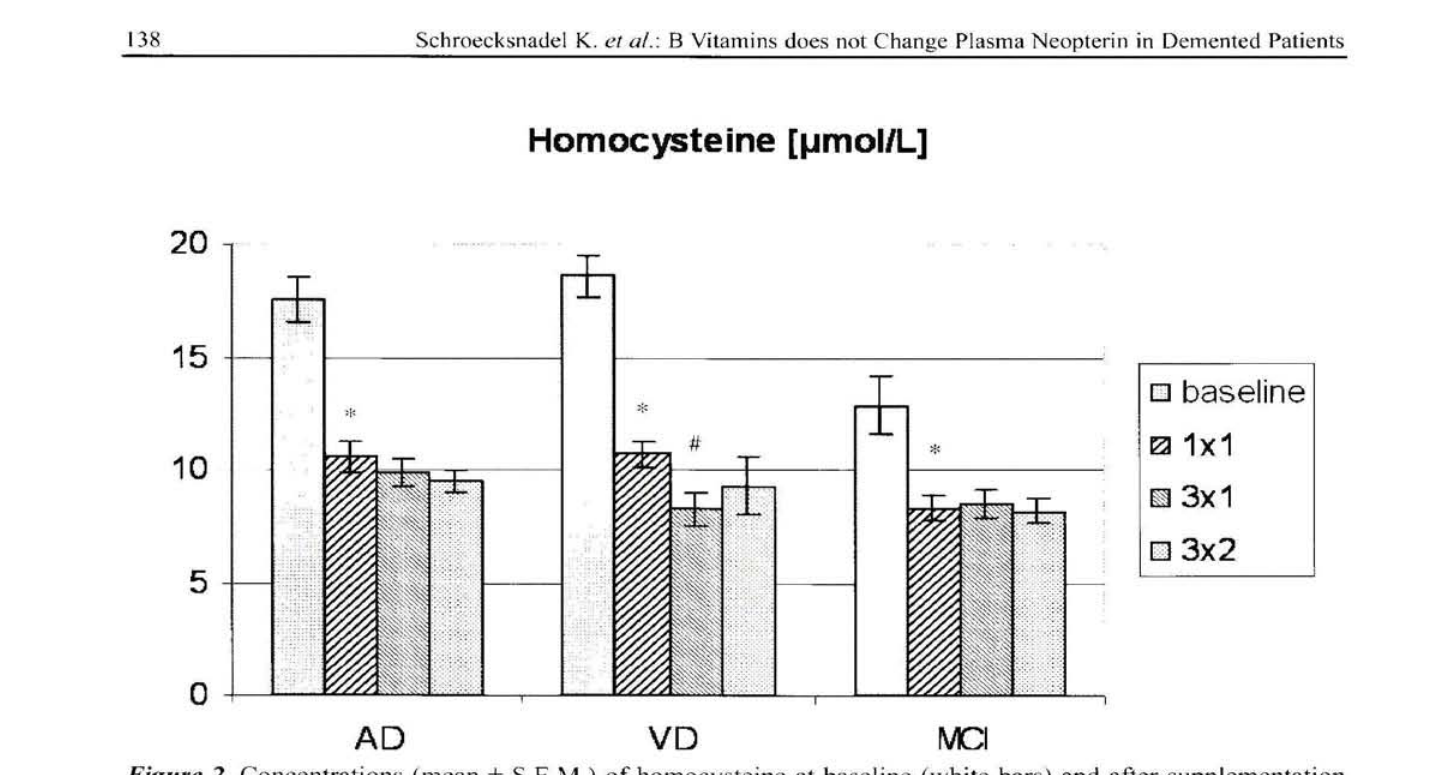
Figure 2. Concentrations (mean ± S.E.M.) of homocysteine at baseline (white bars) and after supplementation with Β vitamins ( Beneuran compositum TM lxl tablet/day, 3X1 tablets/day, 3X2 tablets/day - hatched bars) in patients with Alzheimer disease ( AD), vascular dementia (VD) and mild cognitive impairment (MCI); *p <0.01 compared to baseline, #p <0.01 compared to concentrations at month 1